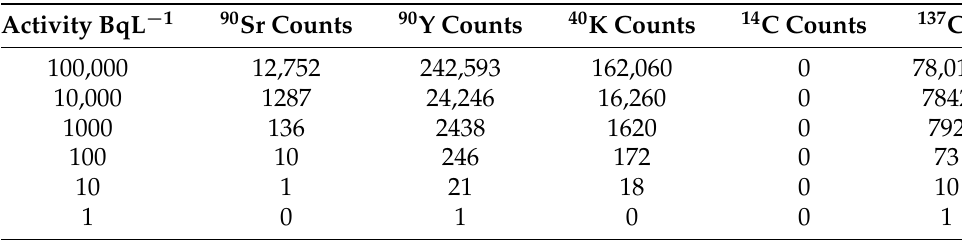
Table 1. The hypothetical number of counts observed in the detector for different radionuclides and activities after a 1-h counting